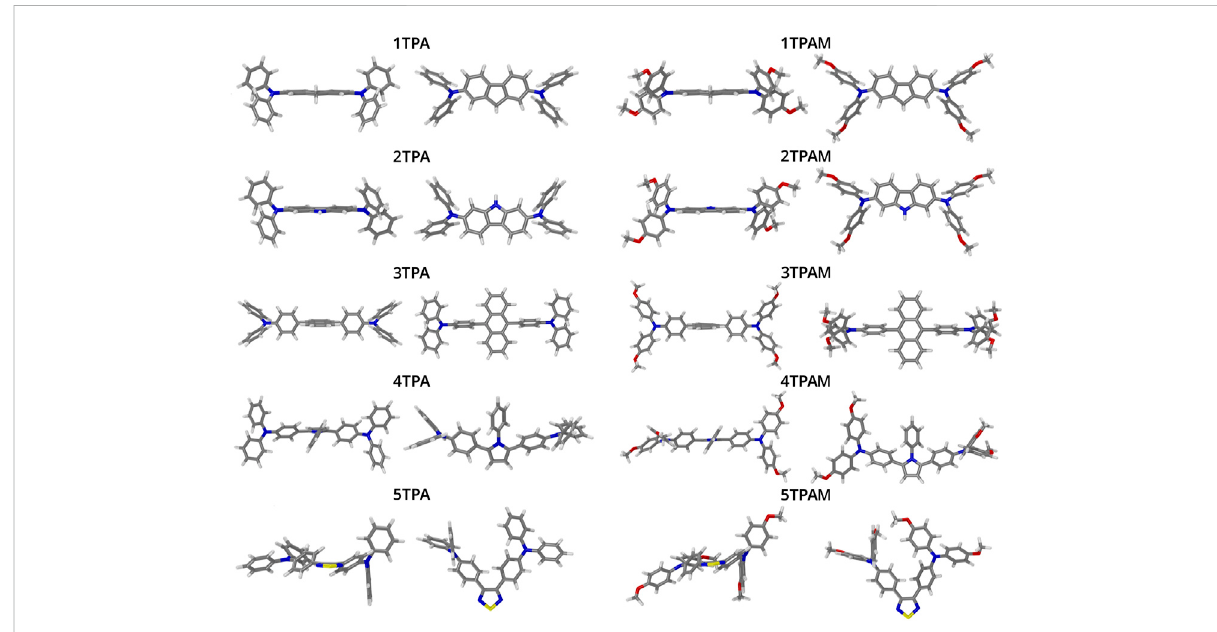
FIGURE 3 Optimized geometrical structures of the triphenylamine derivatives obtained with M06-2X/6-311++G(d,p).